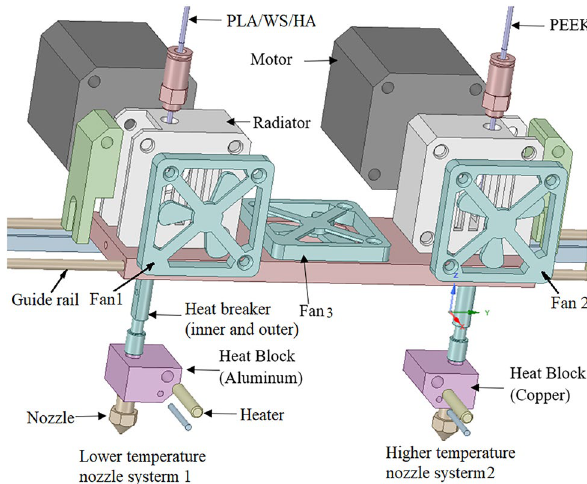
Figure 1. Mechanical structure of the designed nozzle system.